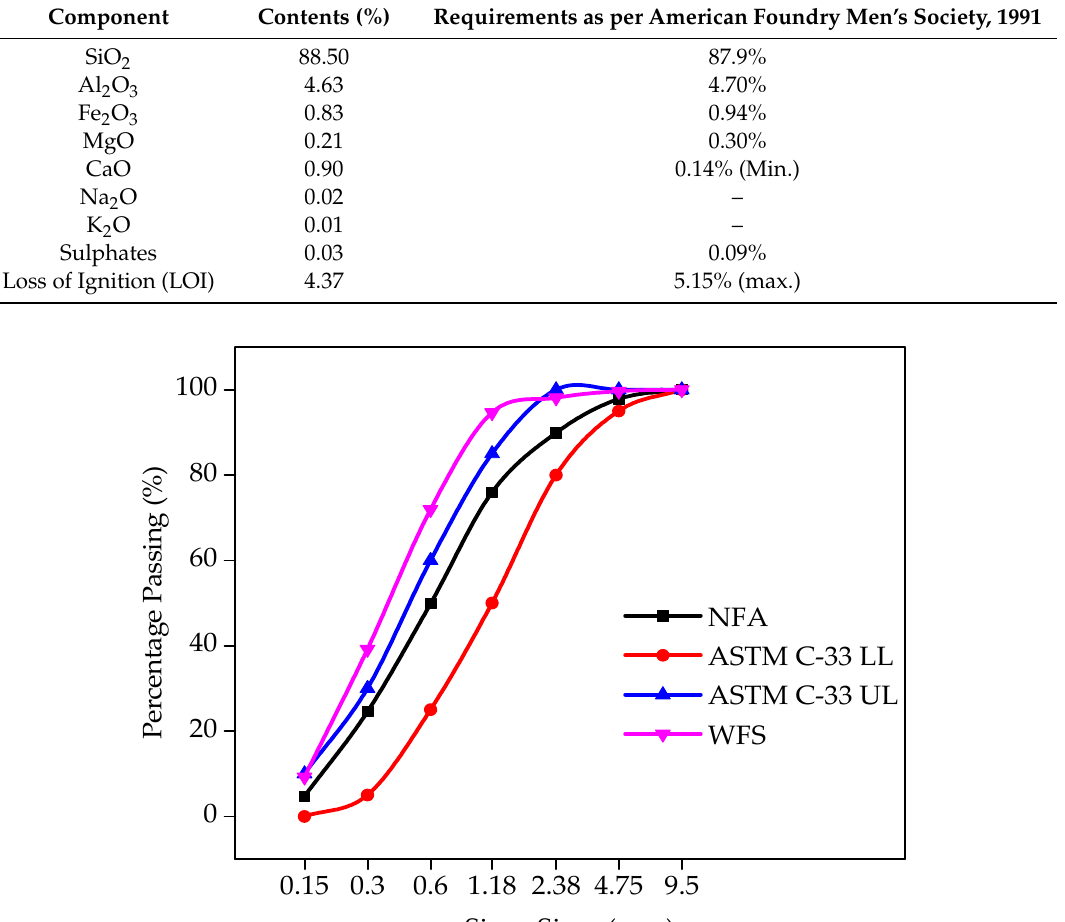
Figure 1. Sieve analysis results of natural fine aggregate (NFA) and waste foundry sand (WFS) in line with ASTM C-33 limits.